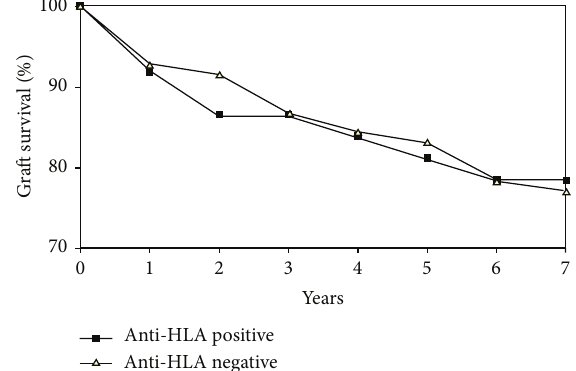
Figure 2: Survival of patients in anti-HLA positive and anti-HLA negative groups. Graft loss occurred in 7 (23%) patients in the anti- HLA positive group and 20 (22%) in the anti-HLA negative group ( 𝑃 = 0.79 , OR = 0.76 [0.26–2.25]).